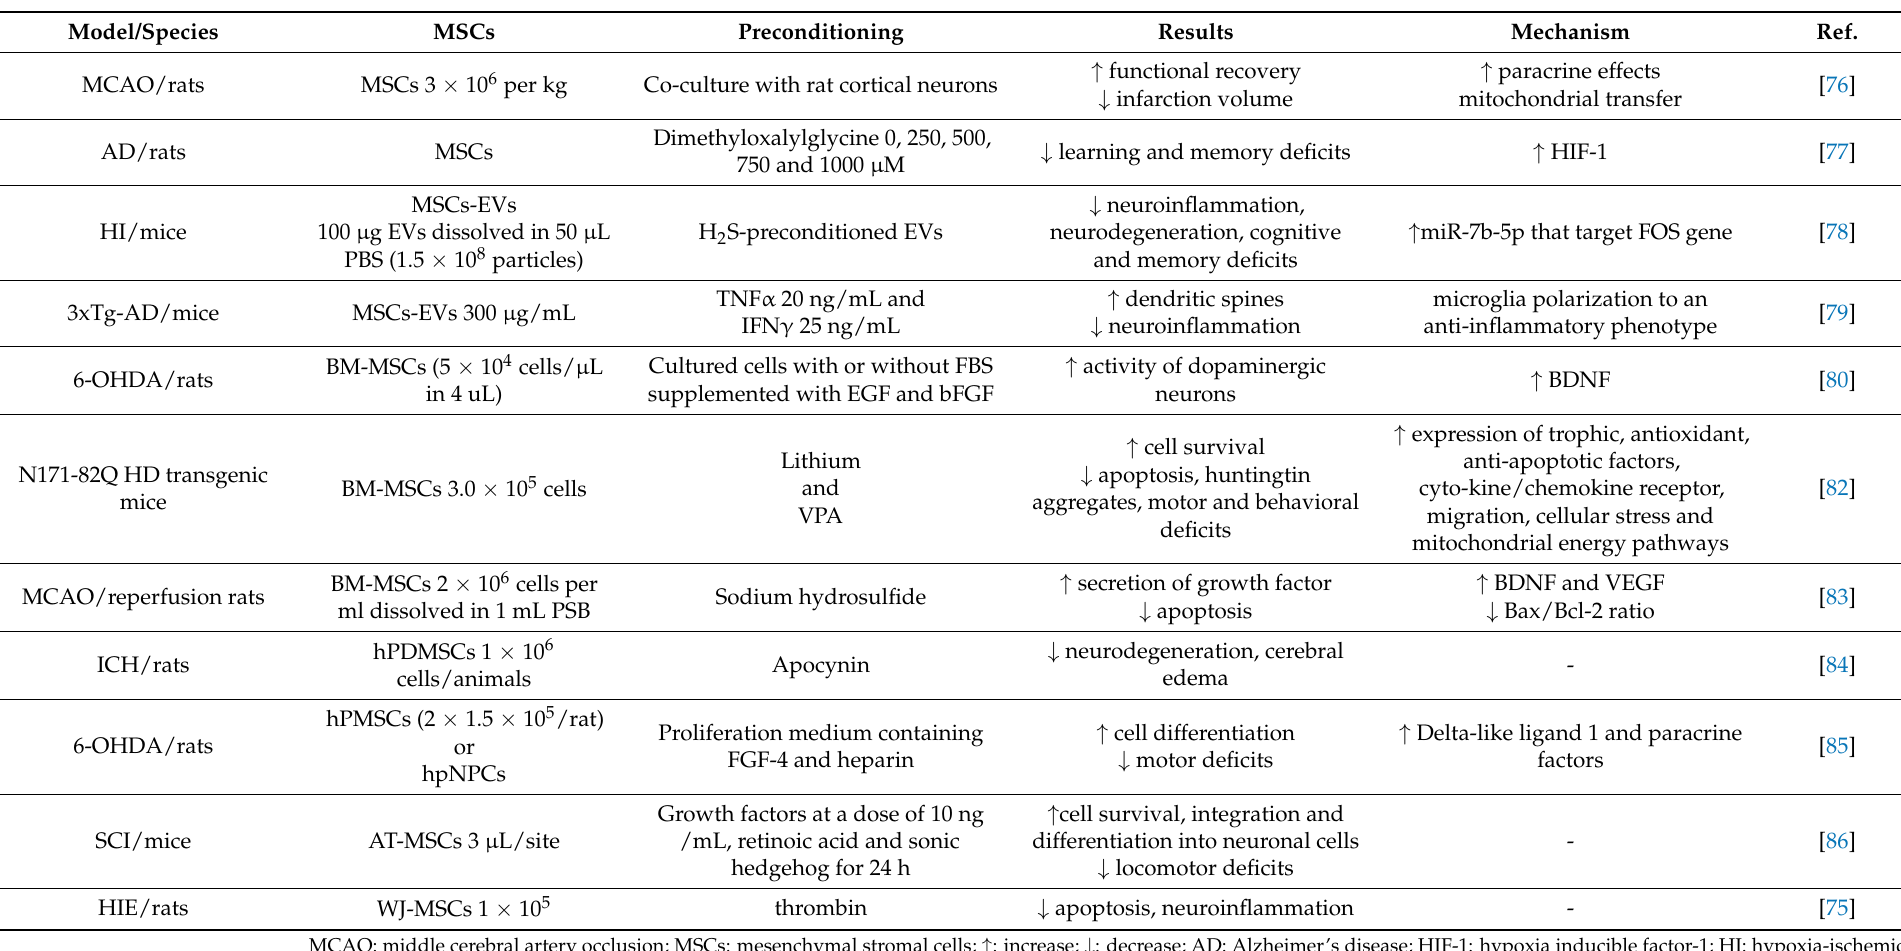
Table 5. Summary of the in vivo studies that described the effects of preconditioning MSCs with chemical, pharmacological agents, trophic factors and